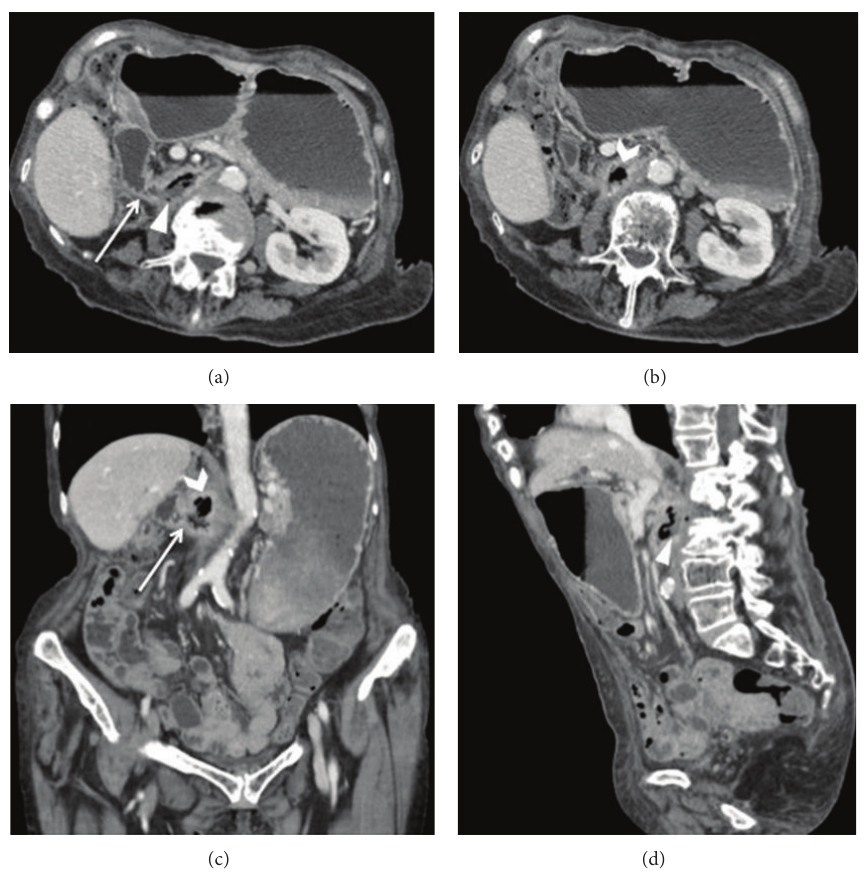
Figure 3: Follow-up contrast-enhanced MDCT study performed three months later. Axial ((a) and (b)) and coronal (c) CT images well show the presence of a fluid-filled fistula (white arrows (a) and (c)) between the duodenum and the IVC graft and an air bubble collection inside the prosthesis (open arrows (b) and (c)). Axial (a) and sagittal (d) CT images better show the path of enteric fluid into the IVC graft. Dilatation of the stomach with an air-fluid level and thickening of the duodenum are also